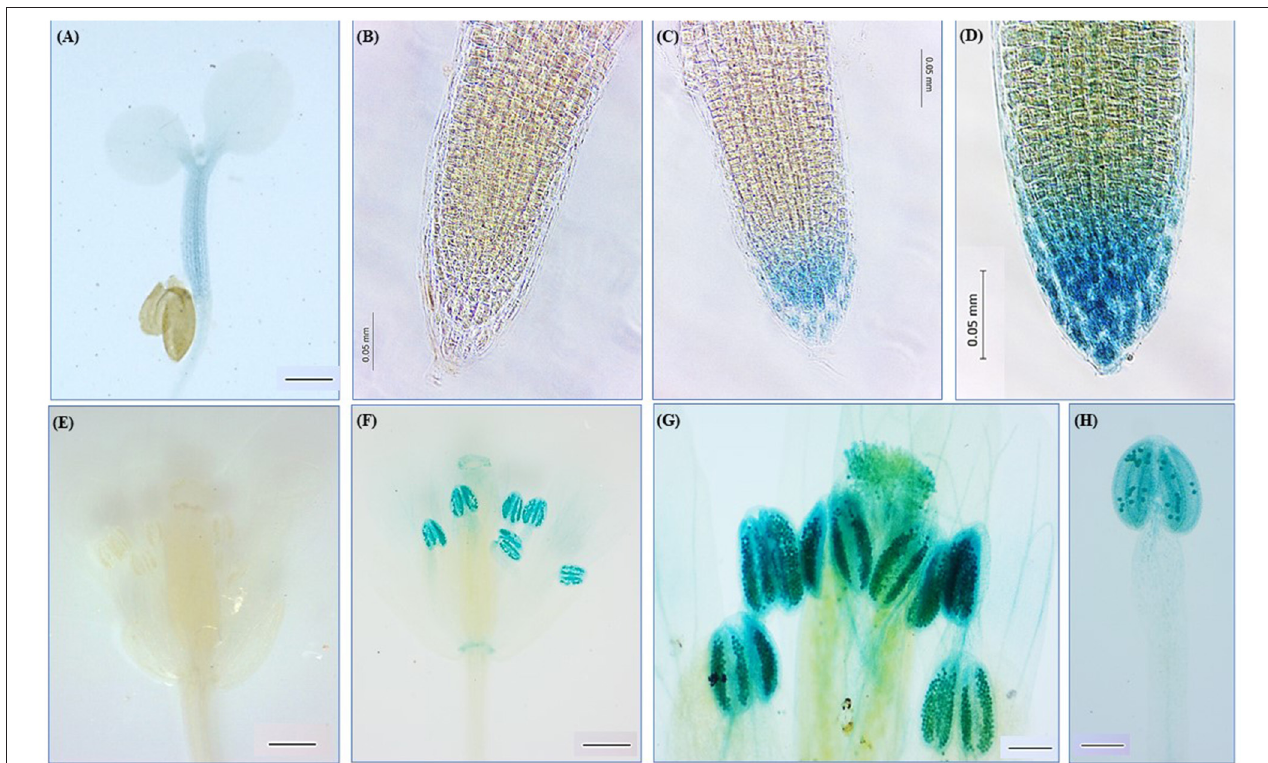
FIGURE 3 | Histochemical assay of β -glucuronidase (GUS) activity in transgenic Arabidopsis thaliana plants expressing the AhN4L-1 promoter-GUS fusion gene. GUS activity was detected in the stem of germinated seedlings (A) , the root tips (C,D) , and the stamens and pistil (F–H) of transgenic plants. Images of roots (B) and flowers (E) of untransformed WT controls are shown. Bars = 100 µ M in (A) ; (E,F) and 0.05mm in (B–D,F–H) .